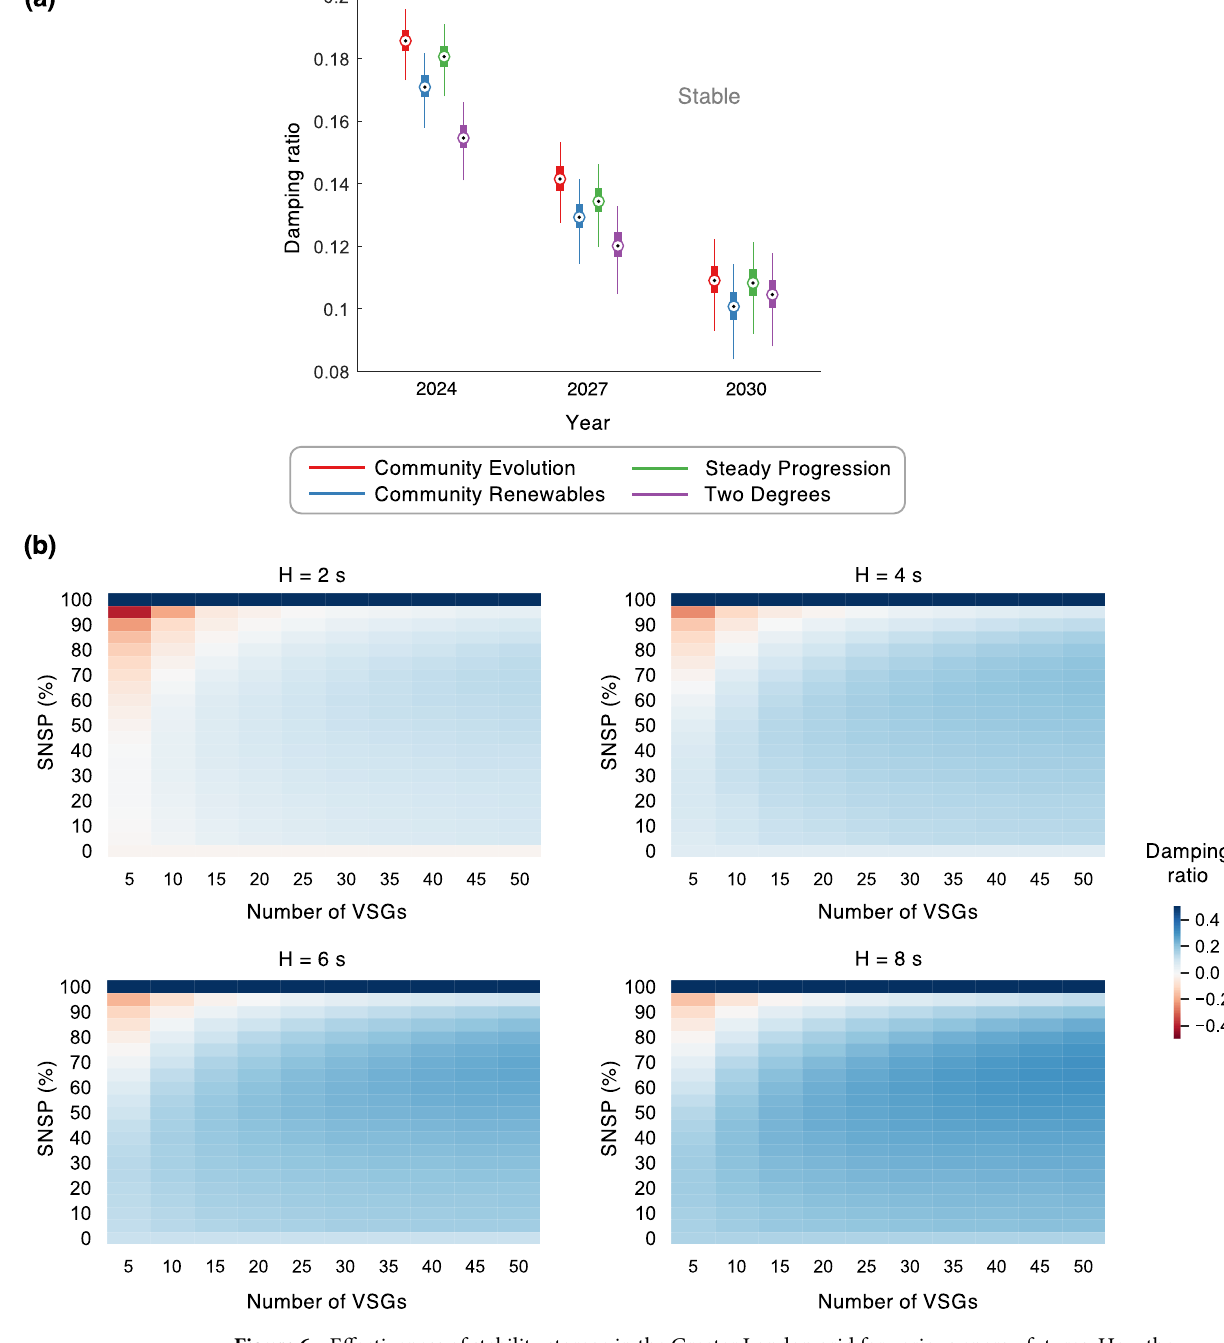
Figure 6. Effectiveness of stability storage in the Greater London grid for various energy futures. How the stability of the projected grids in ( a ) Fig. 1b, and ( b ) Fig. 1c changes when all VSGs participate as stability stores. The central mark, bottom, and top edges of each box plot in ( a ) represent the median, 25th, and 75th percentiles,